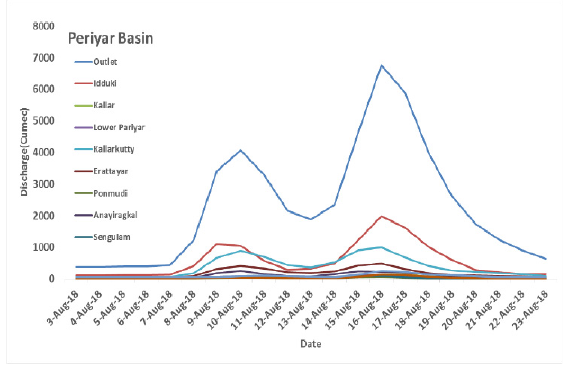
Figure 7. Daily flow obtained from HEC-HMS for outlets and major dams of Periyar river basin.